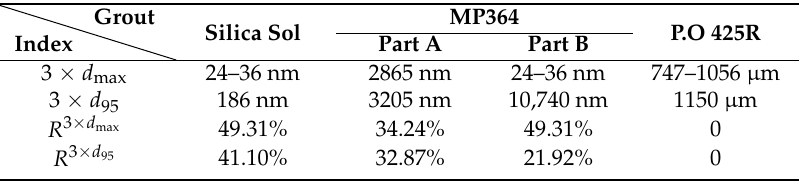
Table 1. Theoretical groutability of different